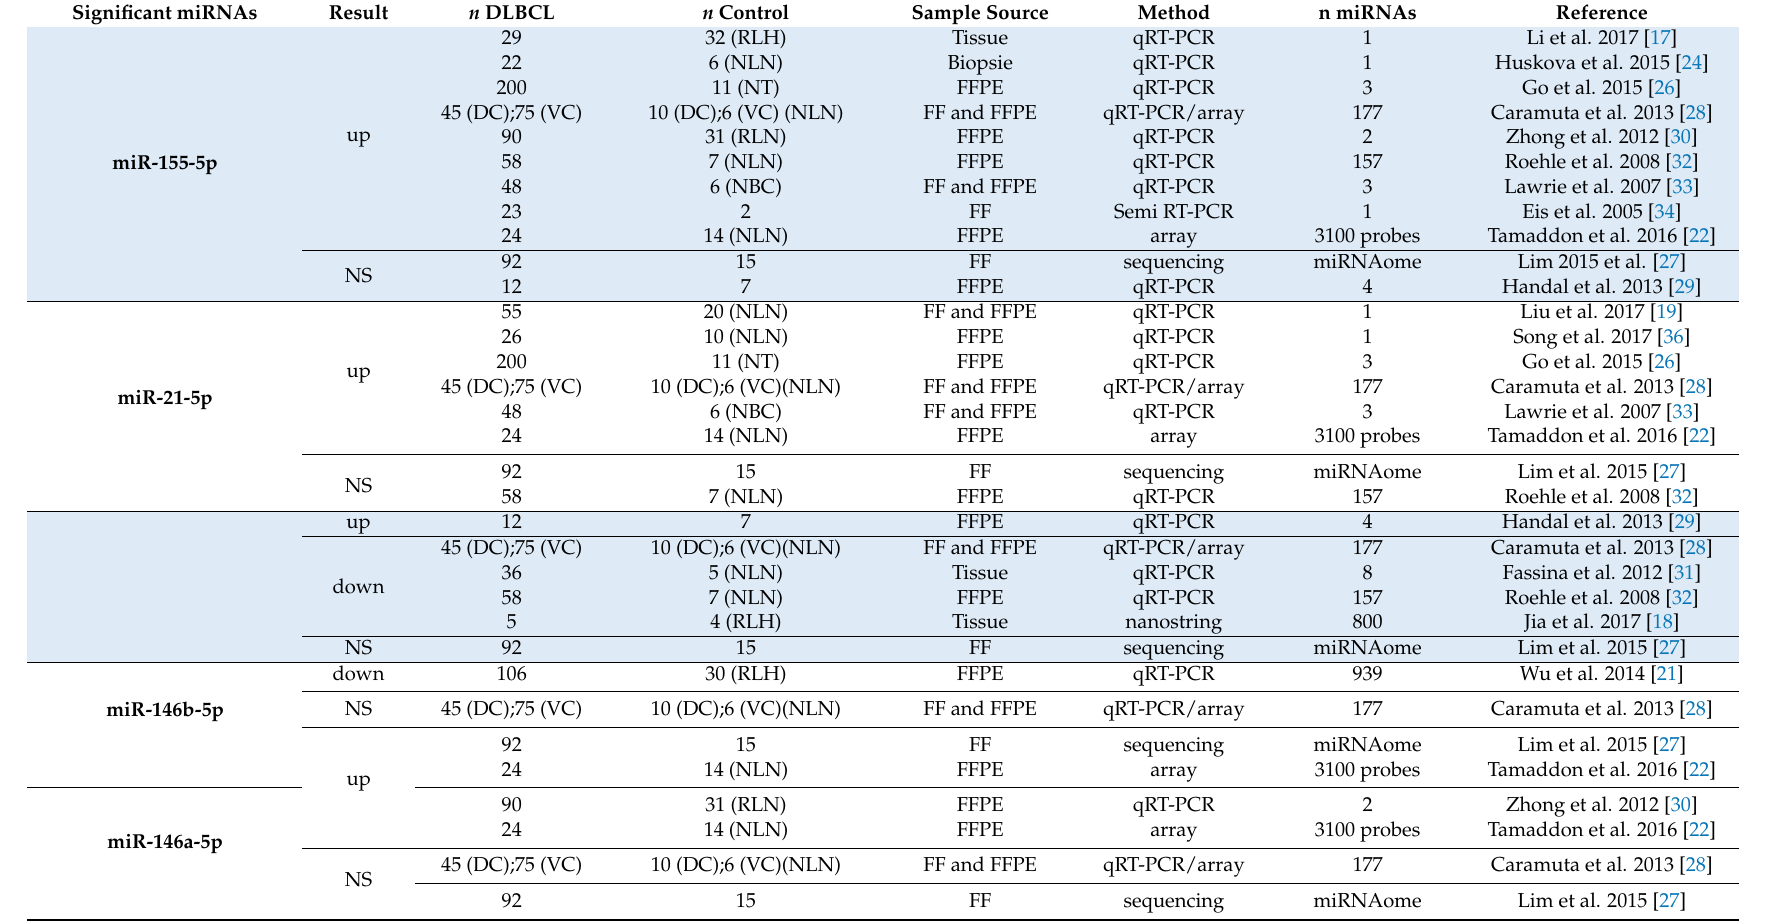
RLH: Reactive lymphoid hyperplasia; NLN: normal lymph node tissues; NT: normal tonsil; FF: fresh frozen; FFPE: formalin-fixed paraffin-embedded; DC: discovery cohort; VC: validation cohort; NBC: normal B cell samples; Up: statistically significantly upregulated in DLBCL patients; NS: no significant difference between patients and controls; Down: significantly downregulated in DLBCL